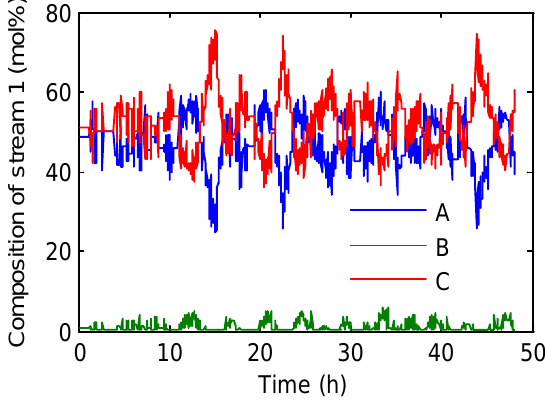
Figure 14. Fault parameter in the base case of fault 8.